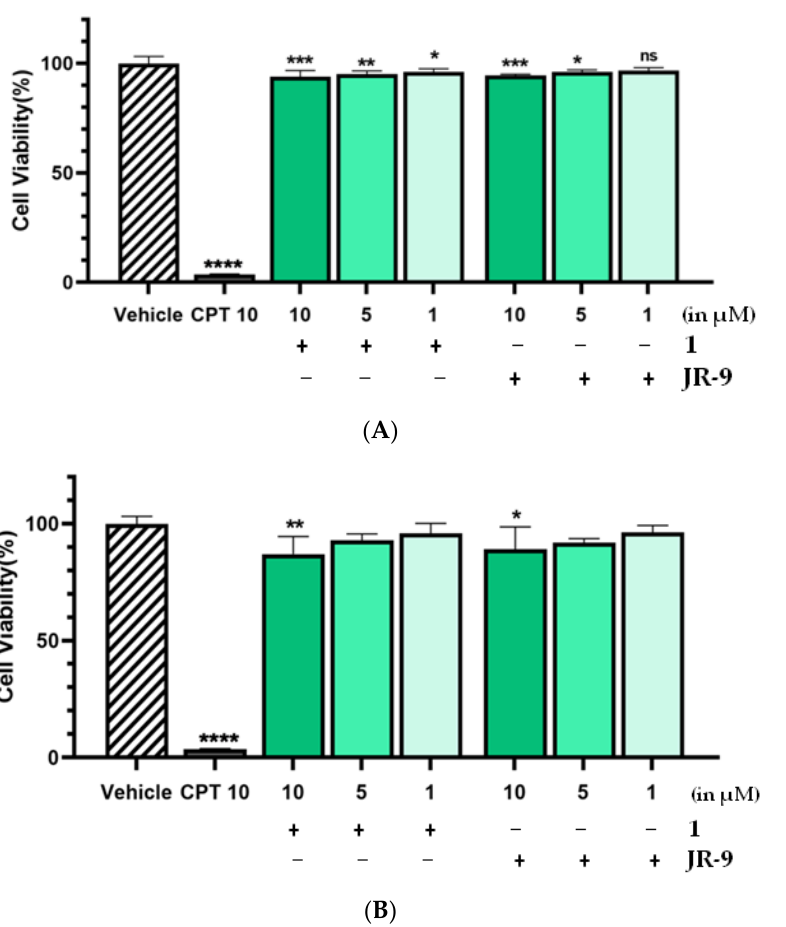
Figure 2. The cells were treated with different concentrations of 1 and JR-9 , and the cell viability was determined by MTT assay after 24 h and 48 h treatment in Figures 2A and 2B, respectively. The results shown are the mean ± standard deviation of three independent experiments. Statistical sig- nificance was assessed by one-way ANOVA followed by Dunnett’s test, **** p < 0.0001, *** p < 0.001, ** p < 0.005, * p < 0.05 vs. vehicle. All the values were mean ± SD, n = 4. CPT: Camptothecin.